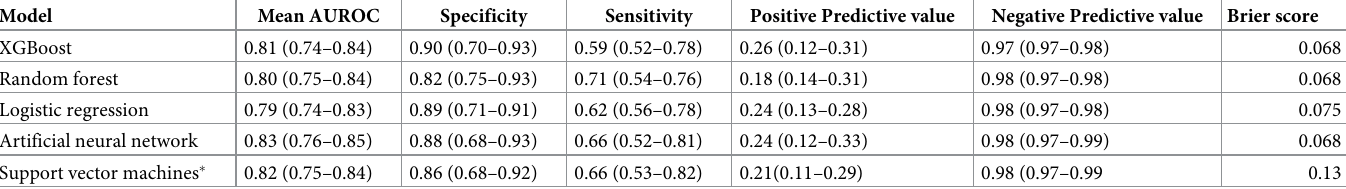
Table 3. Performance of final models for each algorithm with respect to internal 10-fold cross validation on the development set (n = 3,304). The 95% confidence intervals shown in brackets were derived from bootstrap resampling of the development and testing against out of bag samples, repeated 1,000 times. Model